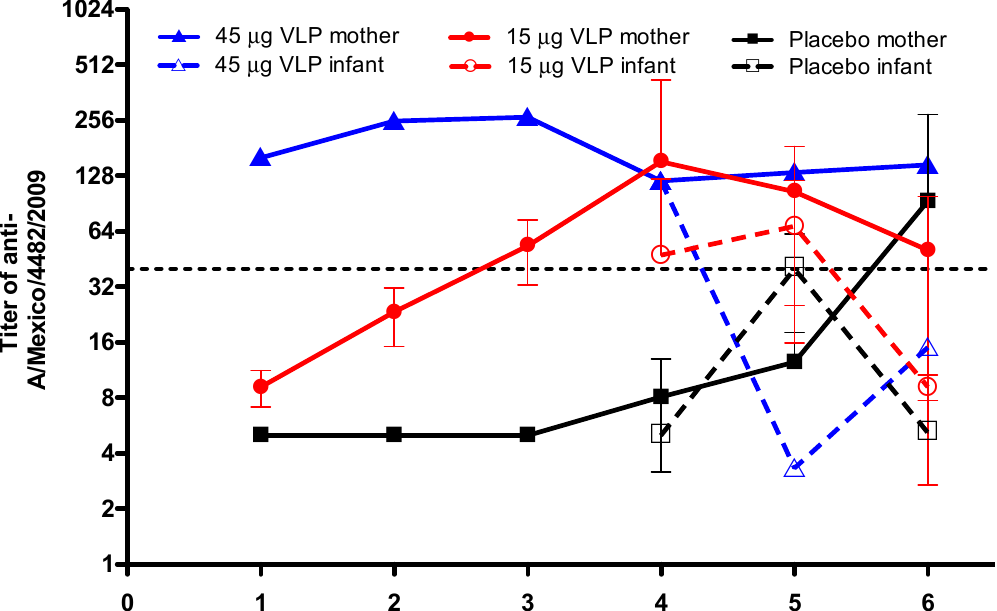
Figure 2. VLP vaccination induces humoral response against the anti-A/Mexico/4482/2009 virus in mothers and infants. Antibody titers in women volunteers vaccinated with 15 µ g VLP ( n = 23), 45 µ g VLP ( n = 1), or placebo ( n = 16). D0—day of vaccination (first dose); D22—day 22 after vaccination (also, two women in the 15 µ g group received a second dose); D36—day 36 after vaccination; birth—day of delivery of the newborns; 6 months—6 months after birth; and 12 months—12 months after birth. Closed symbols and continuous lines show antibody titers in women. Open symbols and dashed lines show antibody titers in infants. Mean ± SD.